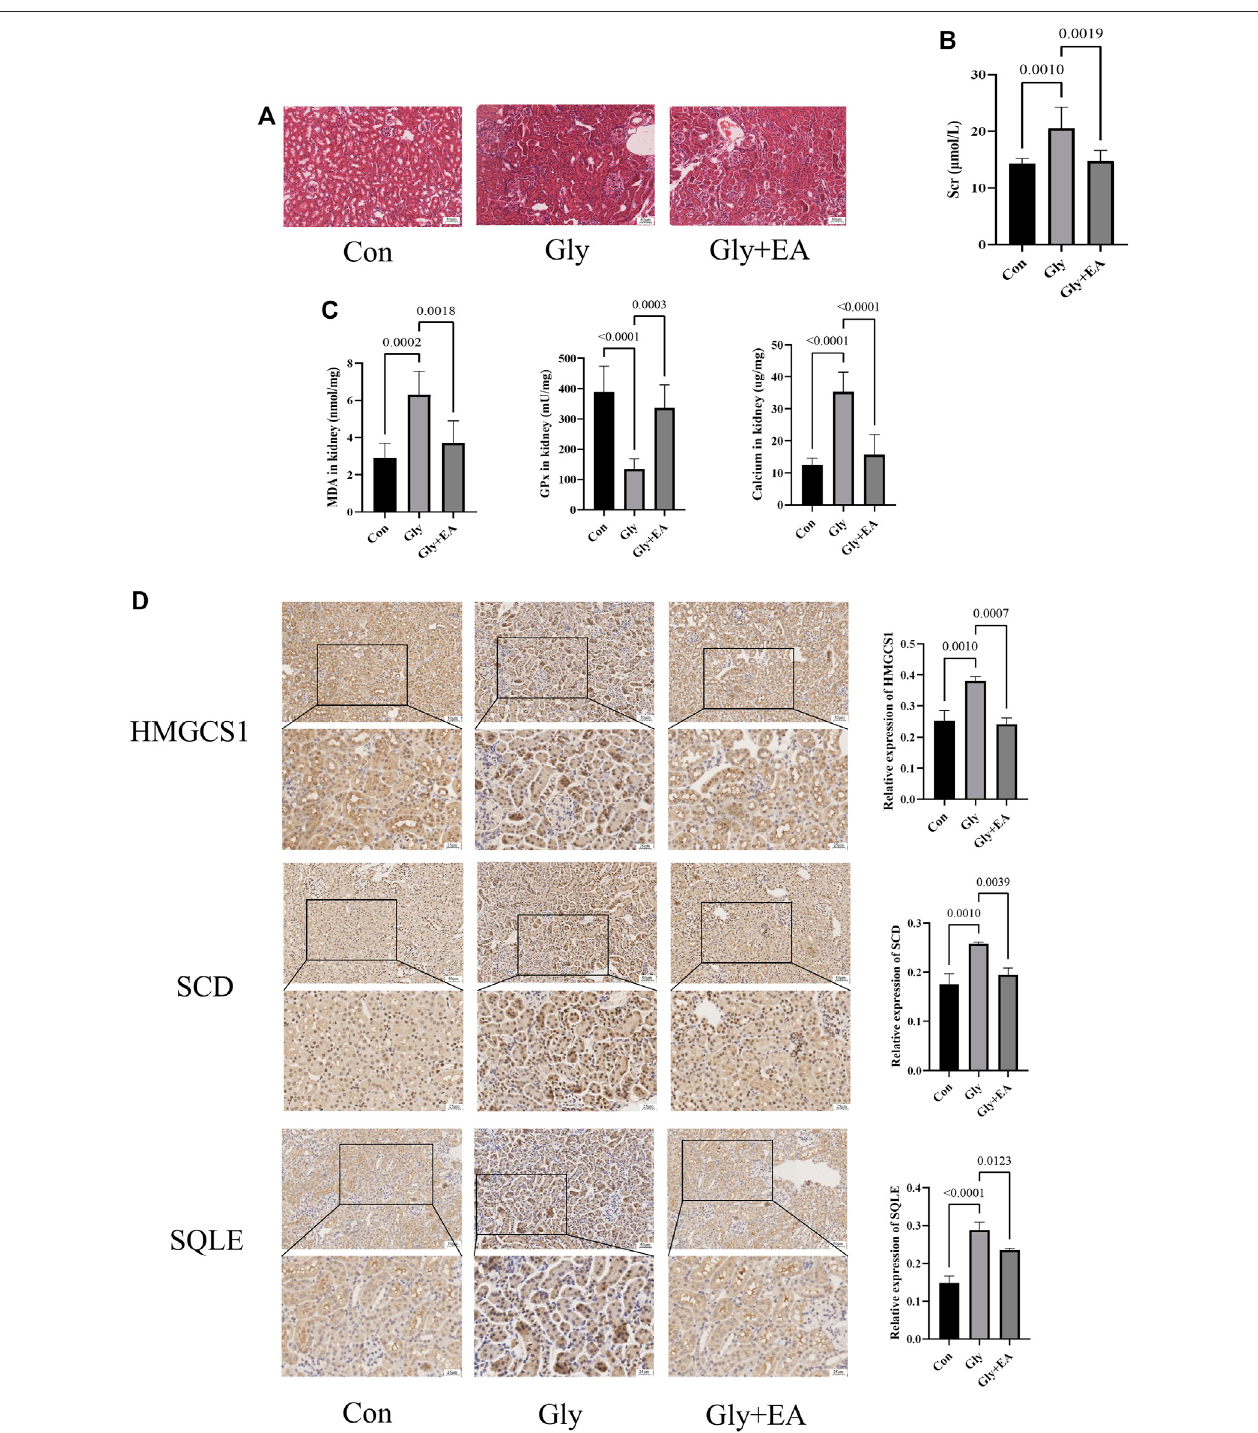
FIGURE 5 | Ellagic acid protects calcium oxalate-induced renal injury in mice and reduces the expression of SQLE, HMGCS1, and SCD (A) Representative light microscopyimagesofhematoxylinandeosinstainingofkidneysfromthecontrolgroup(Con),glyoxylate-inducedCaOxgroup(Gly),andellagicacidtreatmentgroup(Gly + EA) (magni fi cation, ×200; scale bar = 50 μ m) (B) Serum creatinine level in control group (Con), glyoxylate-induced CaOx group (Gly), and ellagic acid treatment group (Gly+EA) (C) TheGPxactivities,MDA,andtotalcalciumcontentincontrolgroup(Con),glyoxylate-inducedCaOxgroup(Gly),andellagicacidtreatmentgroup(Gly +EA) (D) ExpressionofSCD,HMGCS1,andSQLEwereanalyzedbyimmunohistochemistry(IHC)(left)RepresentativelightmicroscopyimagesofIHCstainingofkidney of mice (magni fi cation, ×200; scale bar = 50 μ m (up) and 25 μ m (down)); (right) Semi-quantitative score of SCD, HMGCS1, and SQLE.